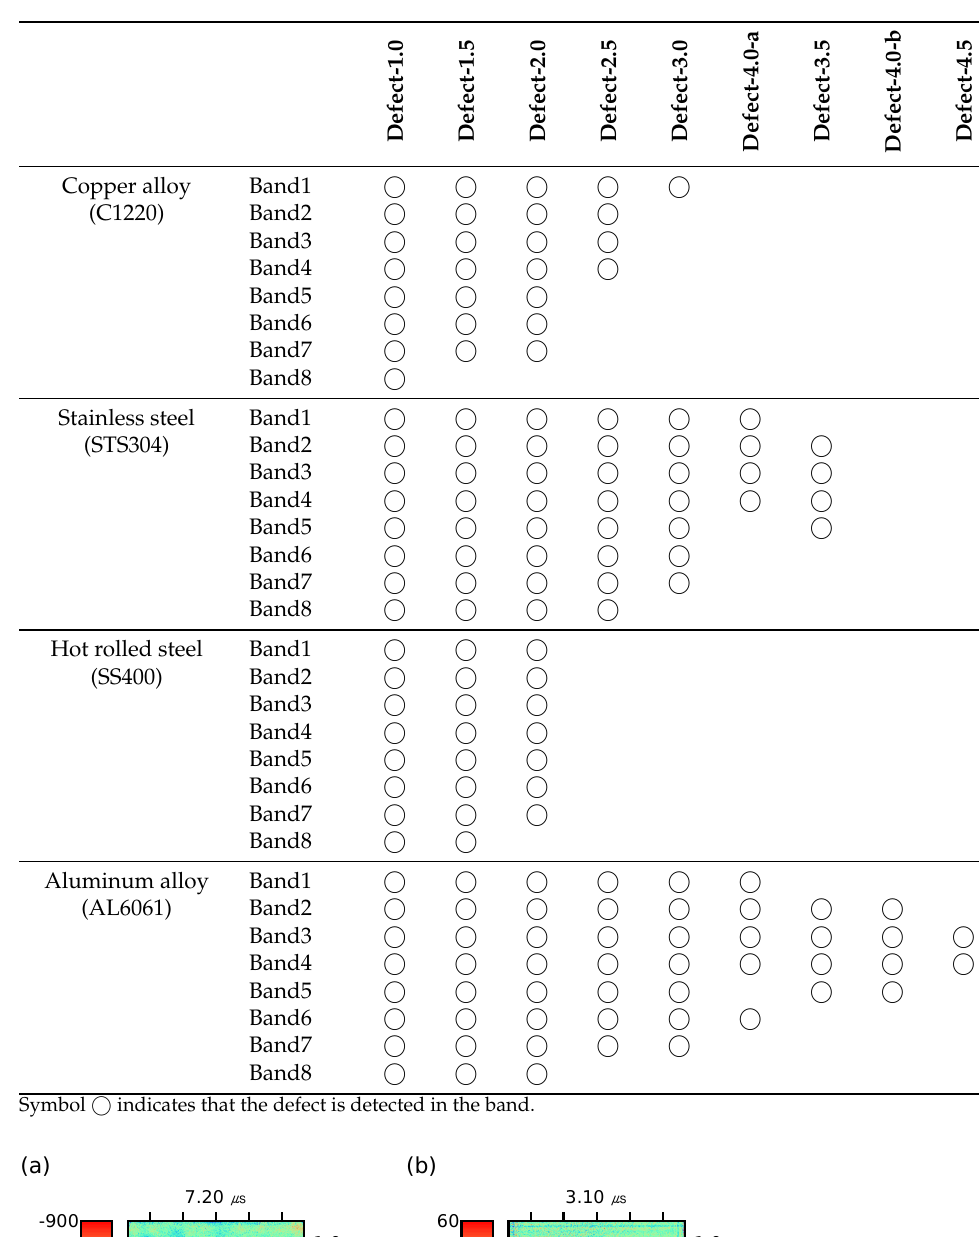
Table 2. Detected artificial defects.